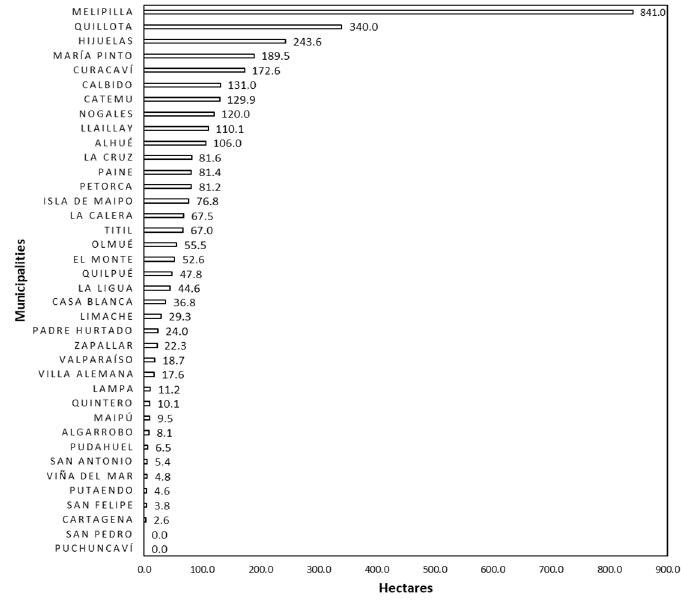
Figure 7. Extension of degraded hillside systems for each commune of the studied area.